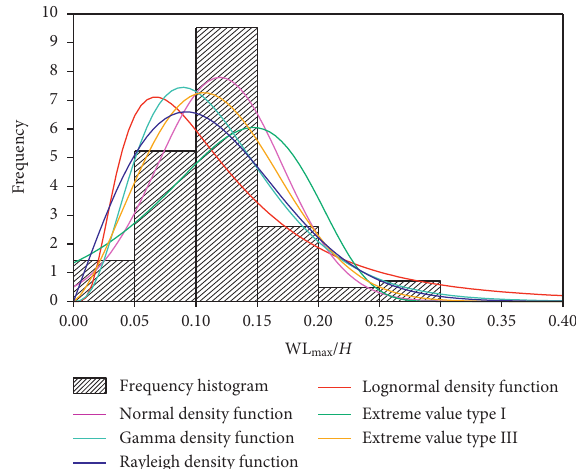
Figure 19: Frequency histogram along the X axis and assumed distribution density functions.